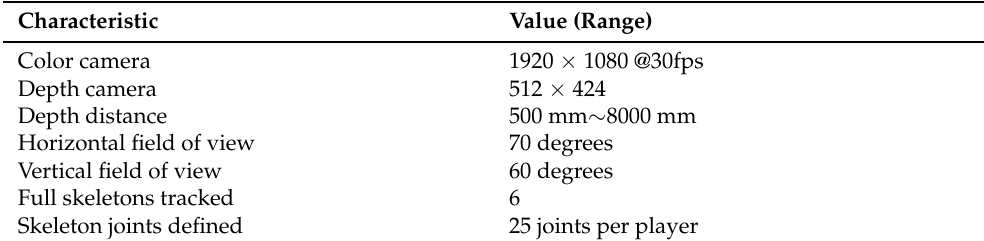
Table 3. Kinect V2 basic characteristics